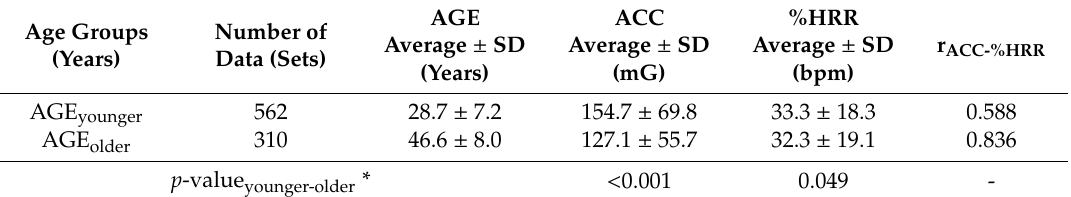
Table 6. Overview of subjects’ age and relationship between ACC and